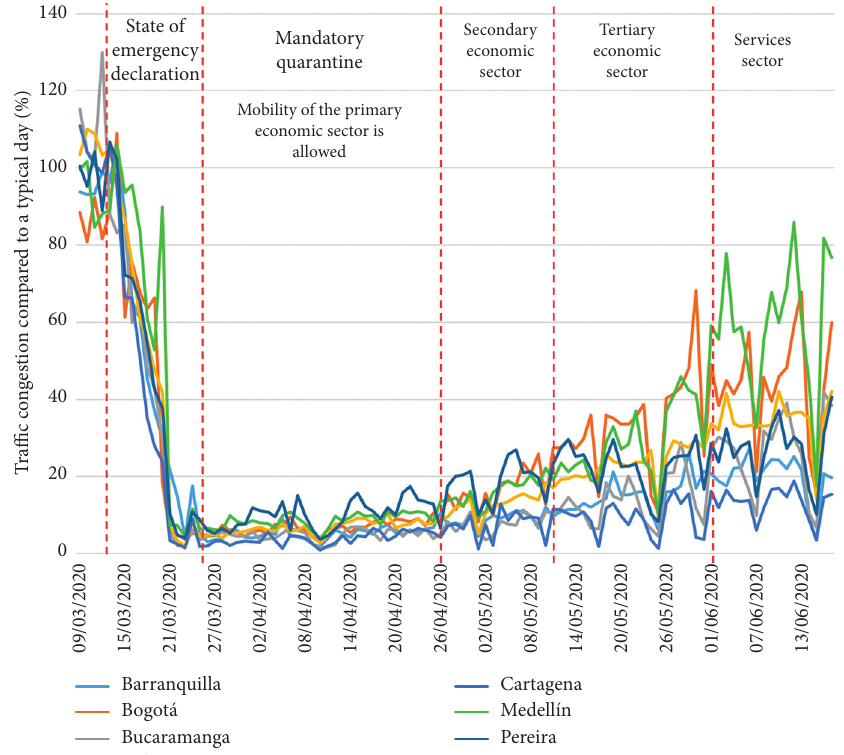
Figure 6: Traffic congestion changes in the seven Colombian cities during March and